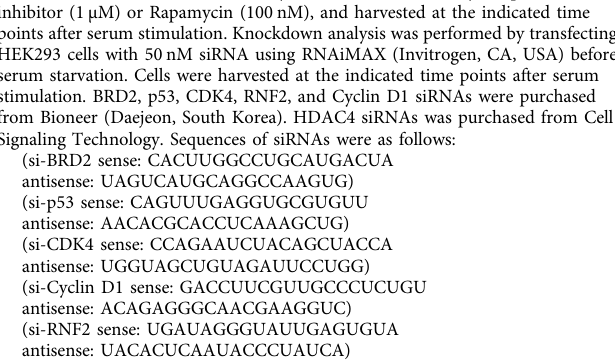
Fig. 7 R-point surveils aberrant oncogene activation. a HEK293 cells were transfected with empty vector (Vec) or Myc-K-RAS G12V . The time-dependent interactions among the components of Rpa-RX3-AC, Rpa-RX3-TR, and Rpa-RX3-RE were measured by IP and IB. Expression levels of ARF, p53, p21, and Myc-K-Ras G12V were measured by IB. b Binding of the components of Rpa-RX3-AC, Rpa-RX3-TR, and Rpa-RX3-RE to the p14 ARF promoter and histone marks (H4K12-ac, H3K27-me3, H3K4-me3, and H2A-K119-Ubi) at the locus were measured by ChIP at the indicated time points. One-thirtieth of